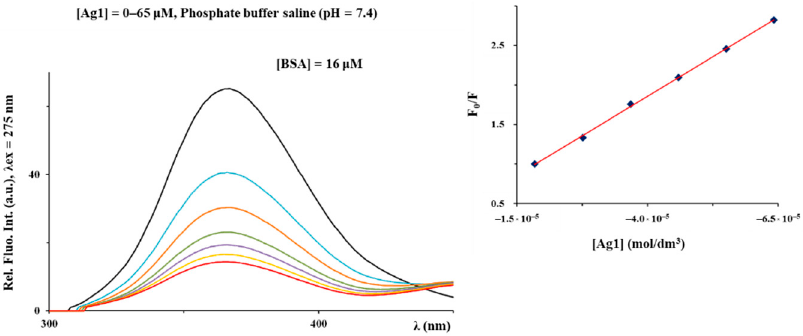
Figure 6. Fluorescence emission spectra of BSA in the presence of an increasing amount of Ag1 complex. The arrow shows the intensity changes upon the gradual addition of the complex. Inserted graph: Stern-Volmer plots of F 0 /F vs. complex.